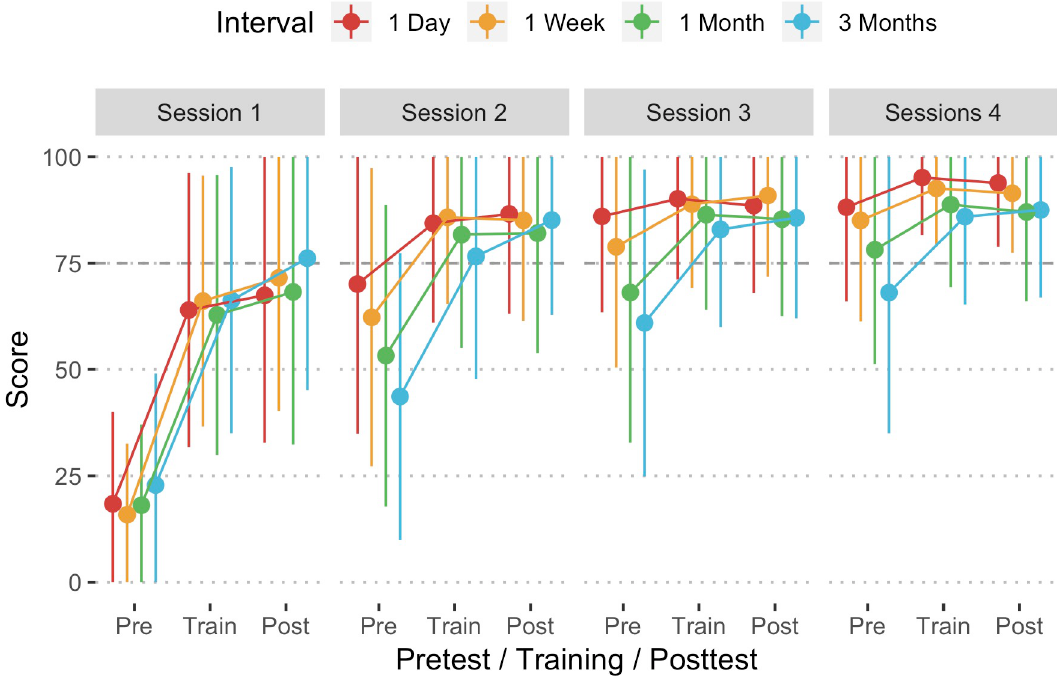
Fig 4. Mean overall ventilation score (1 SD Error Bar) by interval, session, and pretest/training/posttest assessment. Horizontal dashed line at 75 represents the minimum performance target.